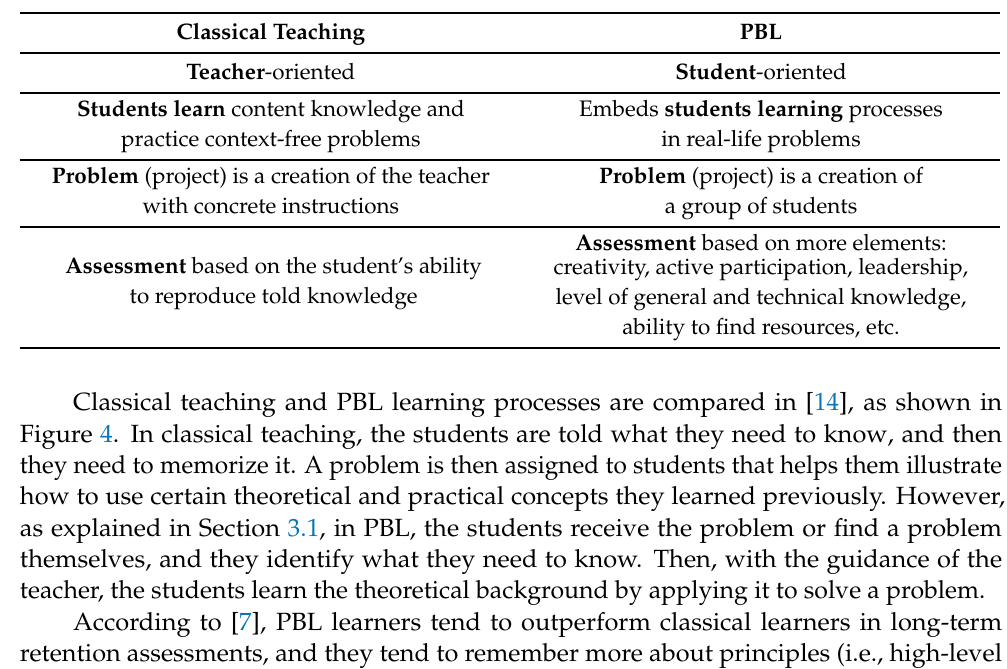
Table 4. Classical teaching vs.